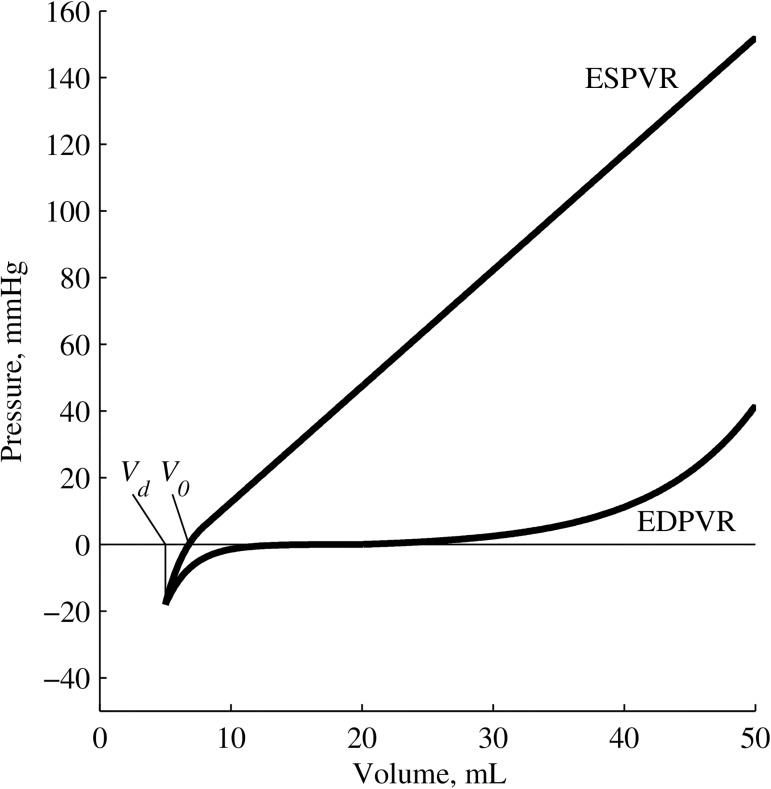
The ESPVR, V0 and Vd.Definitions as in [1].